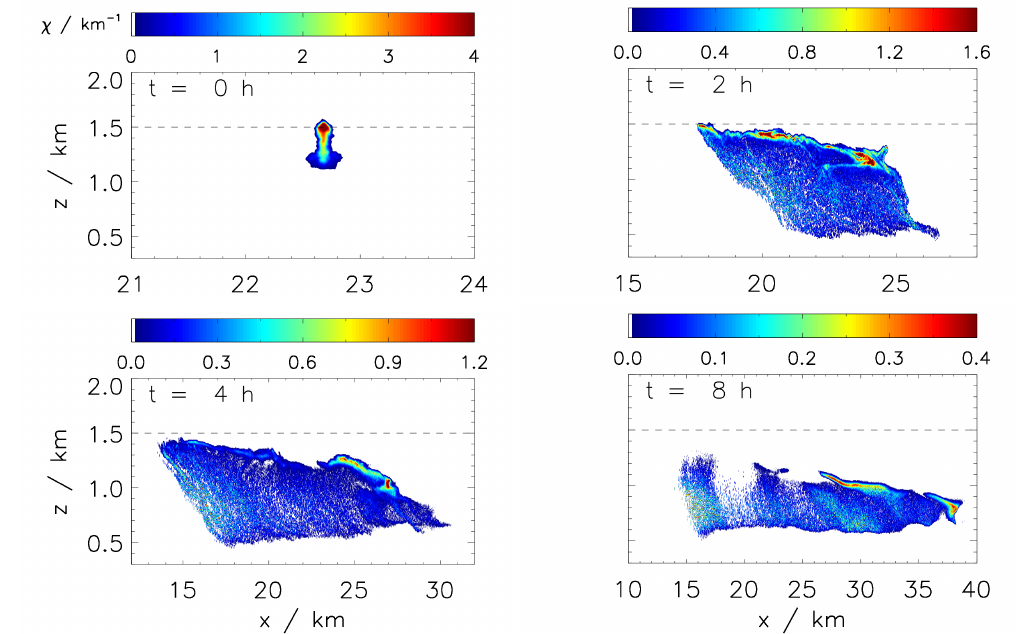
Figure 4. Contrail-cirrus cross-section coloured by the extinction coefficient χ at four different ages (see inserted time labels). Note that the ranges of the colour bars and the x -axes change over time as χ decreases in the spreading